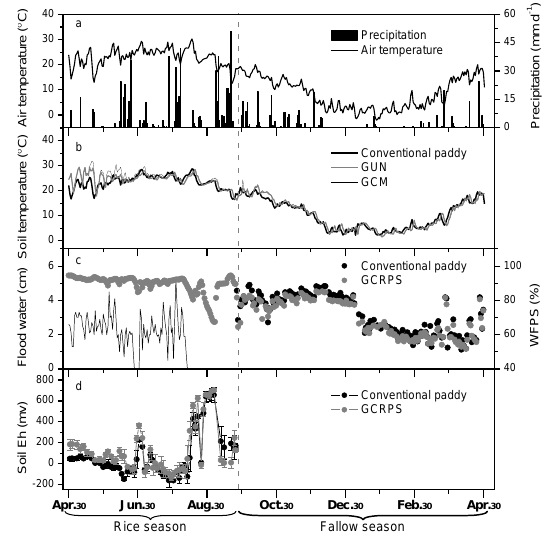
Fig. 1. Figure 1. The dynamics of (a) daily precipitation and mean air temperature, (b) daily mean soil temperature for the conventional paddy and ground cover rice production system (GCRPS) with urea (GUN) and chicken manure (GCM) applications, (c) floodwater depth during the rice-growing season for the conventional paddy and water-filled pore space (WFPS) at 0–6cm soil depth and (d) soil redox potential ( E h , mean ± standard error) at a depth of 10cm for the conventional paddy and GCRPS during the rice–fallow rotation cycle of